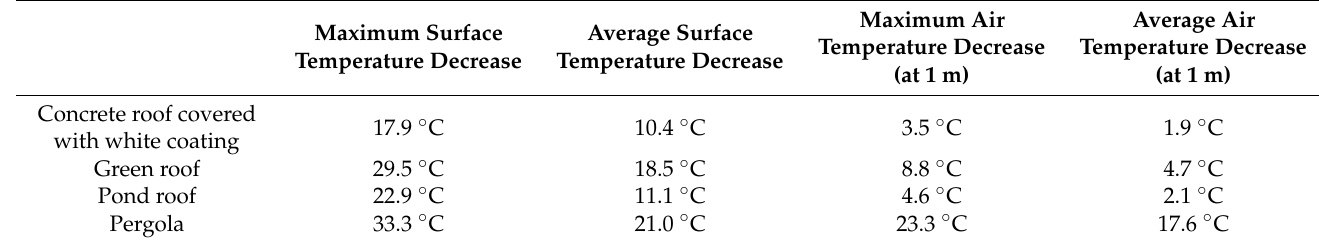
Table 4. Performance of the four roofs in the hot and arid climate (Riyadh)